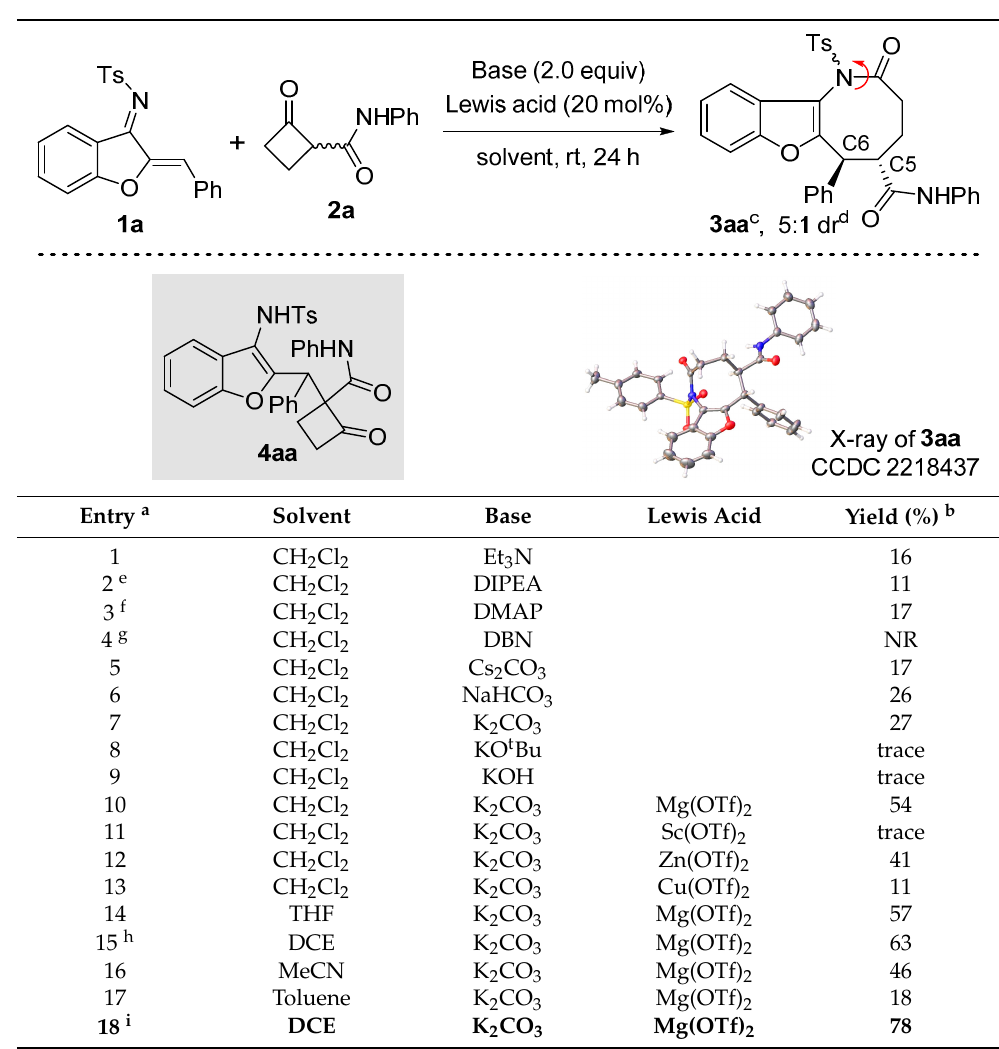
Table 1. Optimization of the reaction conditions. a Reaction conditions: 1a (0.1 mmol), 2a (0.11 mmol), base (0.2 mol), Lewis acid (0.02 mol), solvent (1.0 mL), Ts = 4-toluenesulfonyl, rt = room temperature. b Yields of isolated products. c 3aa was obtained as mixture of atropisomers, only C 5 - C 6 trans product was observed. c Relative configuration. d dr was determined with 1 H NMR analysis. e DIPEA = N,N -Diisopropylethylamine. f DMAP = 4-Dimethylaminopyridine. g DBN = 1,5-Diazabi- cyclo[4.3.0]-5-nonene. h DCE = 1,2-Dichloroethane. i The reaction was performed at − 5 °C for 48 h.